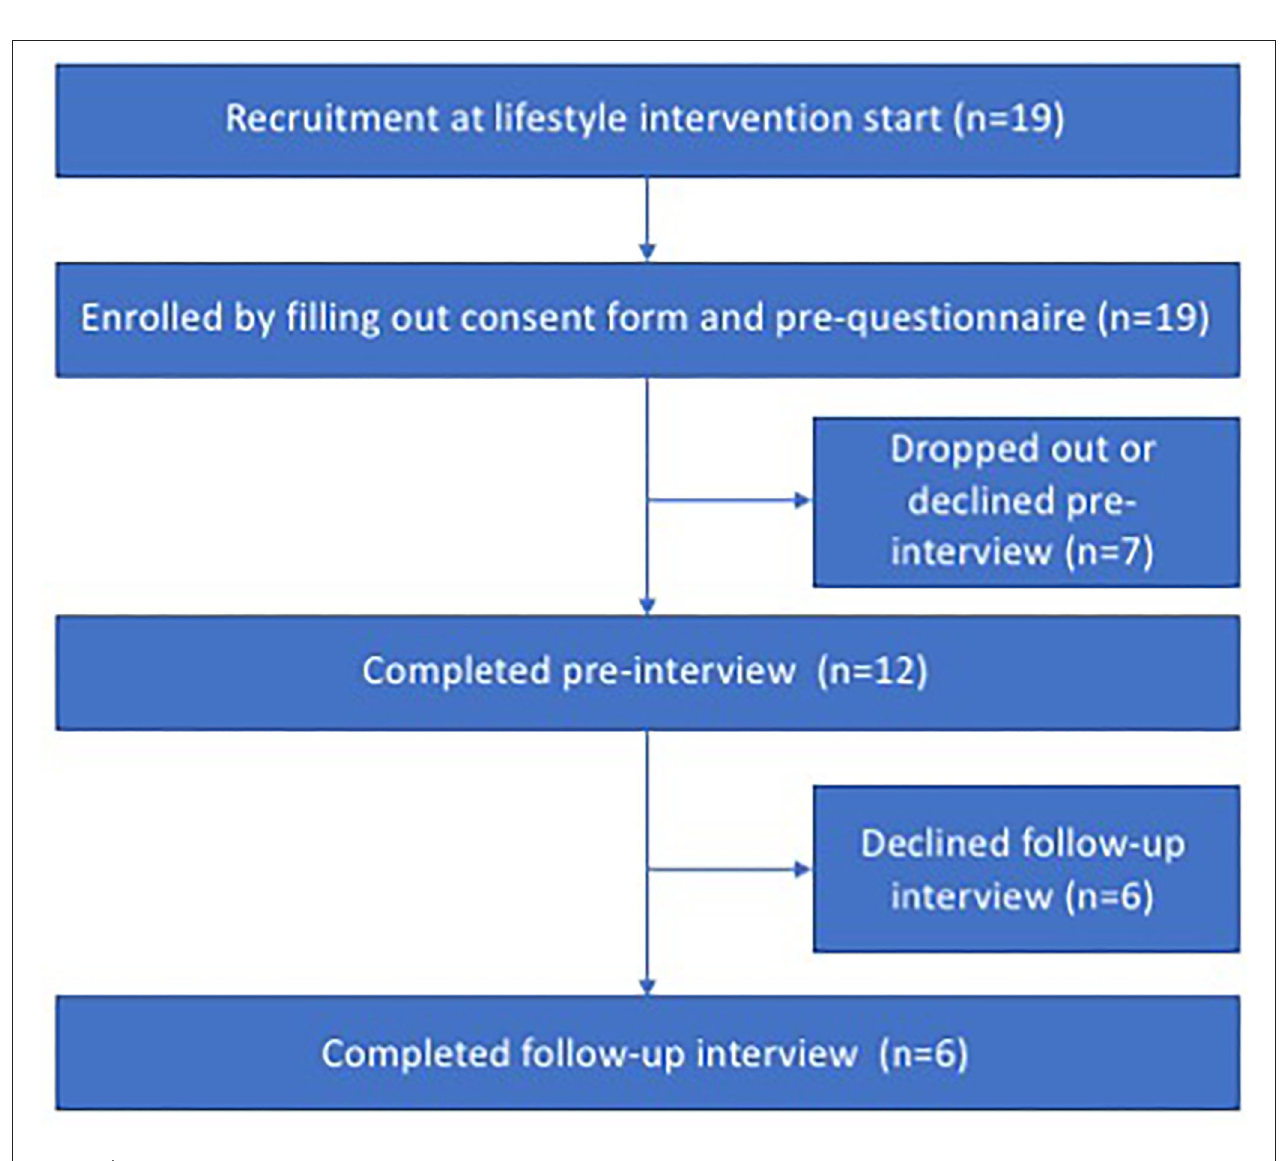
FIGURE 3 | Flowchart recruitment qualitative data